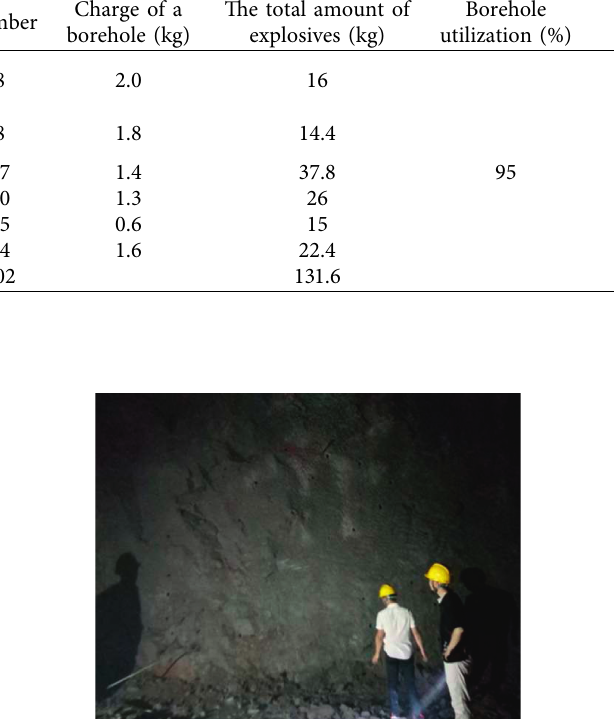
Figure 21: The tunnel face before blasting.